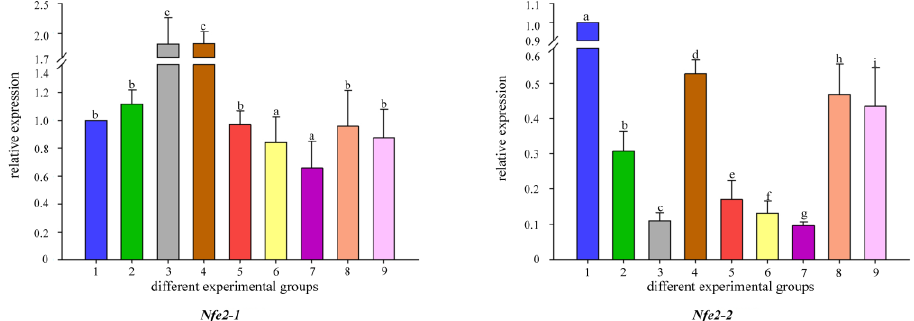
Figure 8. Temporal expression of Nfe2 mRNA relative to control and normalized by qRT-PCR for changes in β -actin in the gut of common carp, challenged for 30 and 60 days. Significant differences between the challenge, infection and control groups are indicated by letters, p < 0.05: 1 is the blank control group; 2 is the heavy metal Cd 2+ -stress group at 30 days; 35 is the B. coagulans group with L1, L2, and L3 concentrations in the feed at 30 days; 6 is the heavy metal Cd 2+ -stress group at 60 days; 79 is the B. coagulans group with L1, L2, and L3 concentrations in the feed at 60 days group.